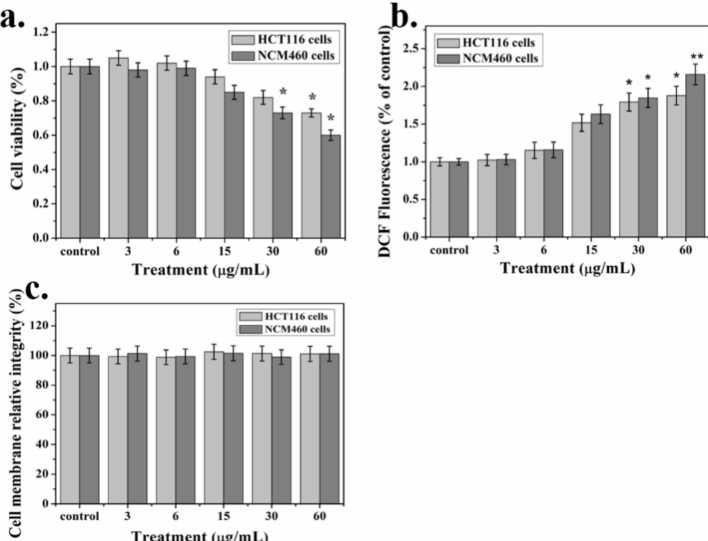
Figure 3. Nano-Ag cytotoxicity test. ( a ) MTT assay for cell viability; ( b ) Intracellular ROS content after exposure to nano Ag; ( c ) The lactate dehydrogenase (LDH) content in the medium was measured to assess the integrity of the cell membrane.